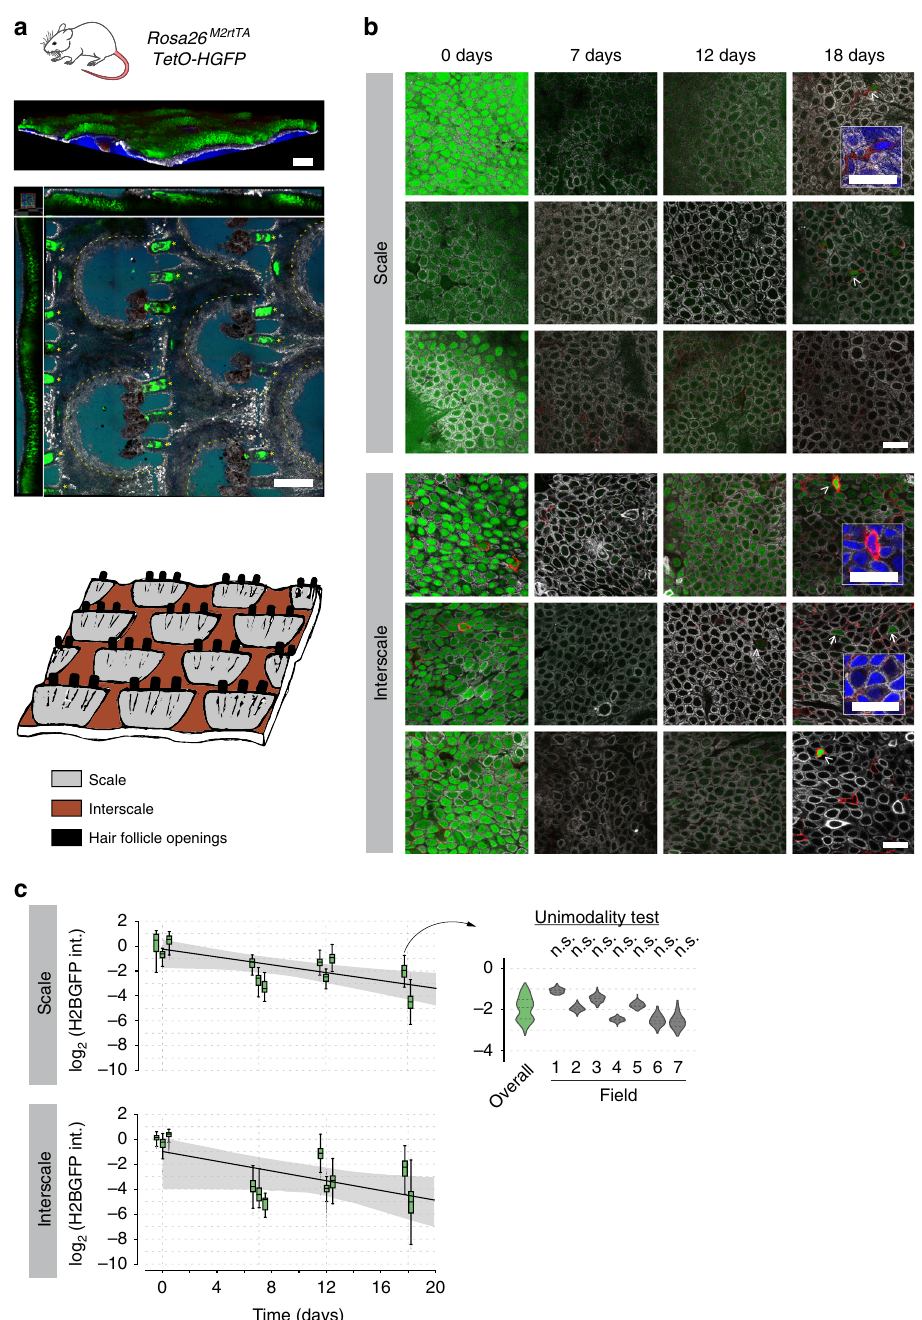
Fig. 5 H2BGFP-dilution analysis in tail epidermis. a Structure of the mouse tail epidermis. 3D reconstruction of confocal z stacks (top panel) and orthogonal xyz view (mid panel). Apical blister-shaped regions (scale) alternate with deeper regions (interscale) (boundaries delineated by dotted lines), being arranged in lines separated by hair follicles (asterisks). Green: H2BGFP expression; white: KRT14 immunostaining (as a marker of basal layer); red: CD45 immunostaining; blue: DAPI. Scale bars, 200 μ m. Bottom panel: Cartoon illustrating the tail skin structure. b Representative confocal z stacks of scale and interscale regions of tail epidermis during H2BGFP chase experiments in R26 M2rtTA /TetO-H2BGFP mice, showing H2BGFP (green), immunostaining for KRT14 (white) and immunostaining for pan-leukocyte marker CD45 (red). Images from the same time point correspond to different mice to illustrate inter- animal variation. Label-retaining cells (LRCs) are highlighted with arrowheads (CD45 + cells) or full arrows (CD45 − cells) (details in inserts; blue: DAPI). Scale bars, 20 μ m. c Time course of basal-layer keratinocyte H2BGFP intensity distributions from scale and interscale regions of tail. Experimental data shown as boxplots per individual biologically independent mouse (intensities normalized to average keratinocyte intensity at time 0, raw H2B-GFP intensity values are given in Supplementary Data 2). n = 3 animals at each time point except 18 days where n = 2 mice. Centre line of box is median value, box indicates 25th and 75th centiles and whiskers indicate minimum and maximum values. Solid black lines: average H2BGFP-dilution rates (within 95% CI limits — shaded gray areas — where the value of λ = 1.2/week reported by Mascre et al. 4 falls). Insert: Detail of H2BGFP intensity distributions separated per fi eld of view for the single tissue found to be bimodal in the overall, per-animal modality test (see Fig. 3d). Analyses per fi eld of view all resulted non- signi fi cant